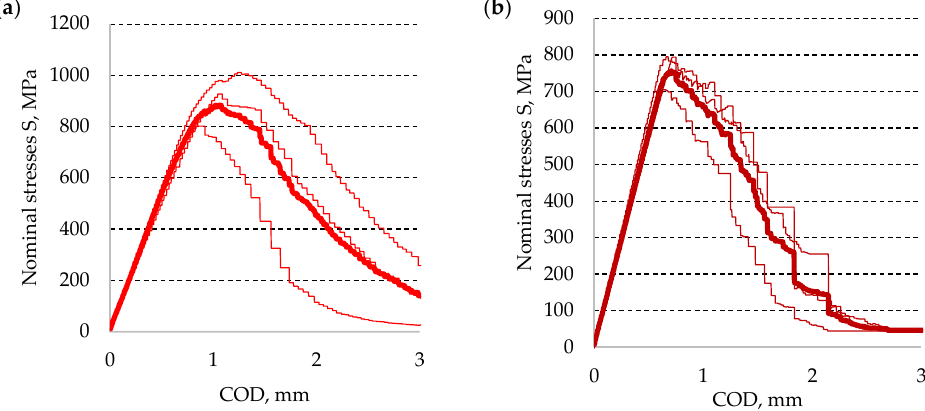
Figure 12. Diagrams of nominal stresses – specimen opening, calculated for Ti6Al4V titanium alloy: ( a ) ambient conditions and ( b ) cryogenic conditions.